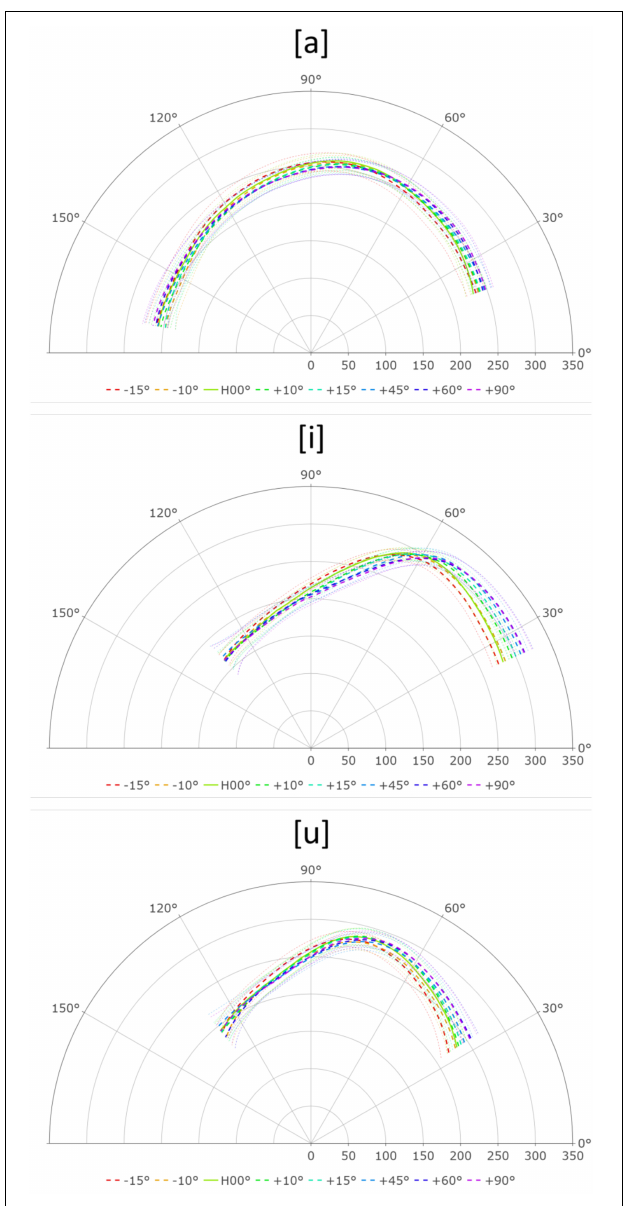
FIGURE 2 | Tongue surface contour for [a], [i], and [u] across the eight head angles. Tongue tip is on the right.